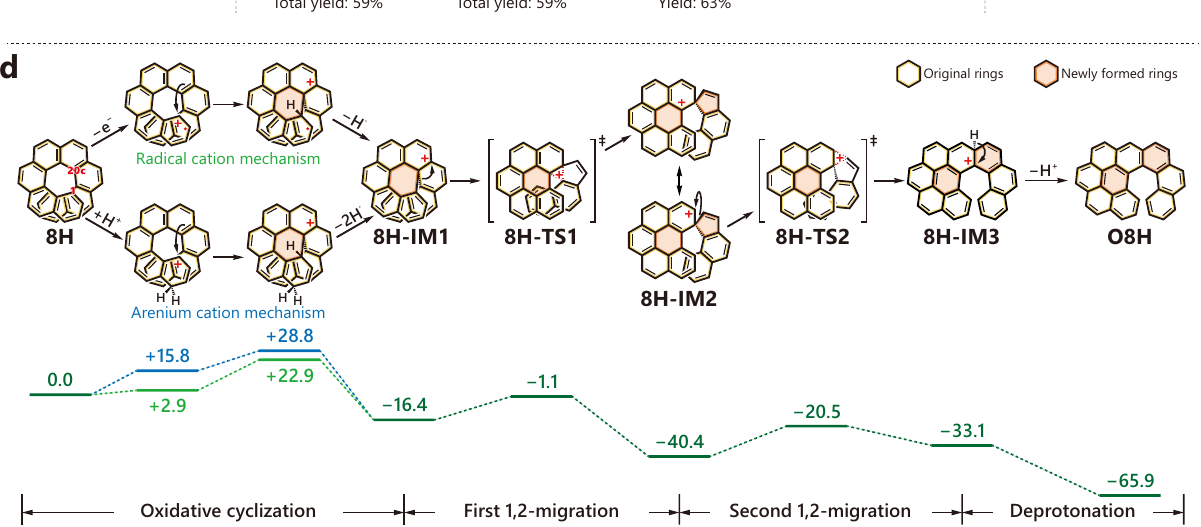
Fig. 2 Oxidative cyclo-rearrangement of carbo[8]helicenes. a Cyclization of [5] and [6]helicene derivatives. b Oxidation of primitive 6H and 8H by 2,3- dichloro-5,6-dicyano-1,4-benzoquinone (DDQ) in various acidic conditions. The crystal structure of O8H is shown in thermal ellipsoid with a 30% probability. c Oxidative cyclo-rearrangement of substituted carbo[8]helicenes. d Proposed mechanism for the oxidative cyclo-rearrangement of 8H . Free energies are given in kcal mol − 1 and the free energy of 8H is set as